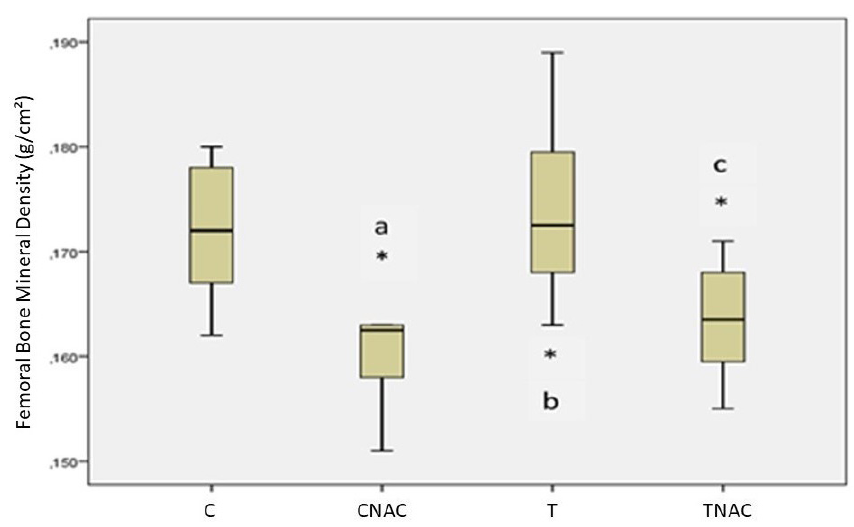
Figure1: Analysis of femoral bone mineral density in the four groups of animals. (a): CNAC different from C and T, (B): T different from CNAC and TNAC, (C) TNAC different from C and T. ANOVA analysis of variance test with significance level of 5% (p <0.05).C: Control; CNAC: Control with N-acetylcysteine supplementation; T: Concurrent Training; TNAC: Concurrent Training with N-acetylcysteine supplementation.